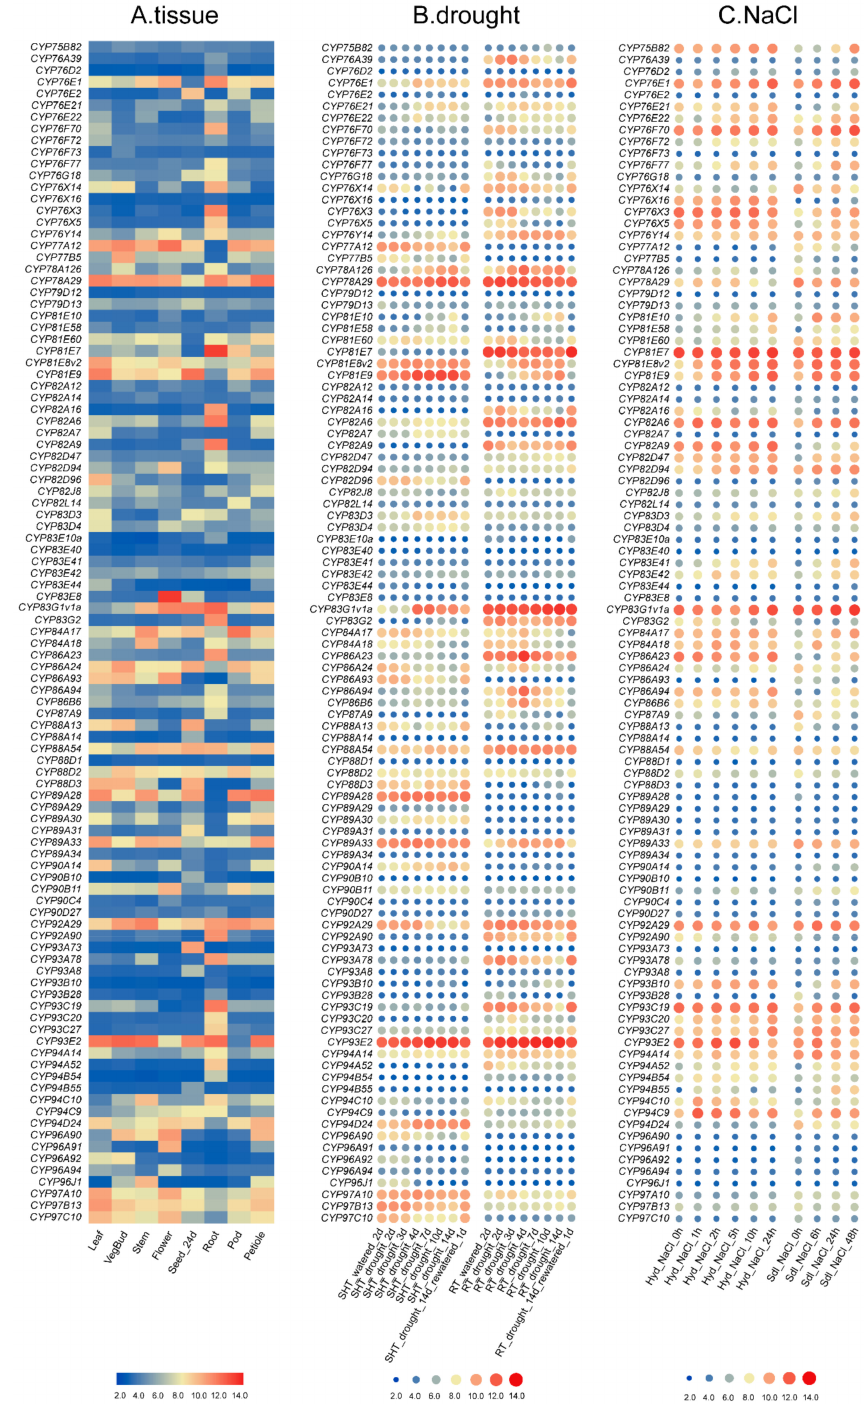
Figure 5. Expression profiles of MtP450 genes. ( A ) Expression profiles of MtP450 genes in eight different tissues from microarray data. ( B , C ) are hierarchical clustering of gene expression profiles under drought ( B ) and NaCl ( C ) treatments from microarray data. Each column indicates a sampling time point, and each row indicates an MtP450 gene, wherein each treatment was normalized in the same row, the relative expressions levels are log2-transformed and visualized by heatmap. The colors vary from blue to red, and circles from small to large represent the scale of relative expression levels. Those genes with deeper background color showed that their expression was significantly increased after stress induction. “SHT” and “RT” stand for “shoot” and “root” materials, respectively, used for drought treatment; “Hyd” and “Sdl” stand for hydroponic treatment with 200 mM NaCl, and in vitro culture with 180 mM NaCl,